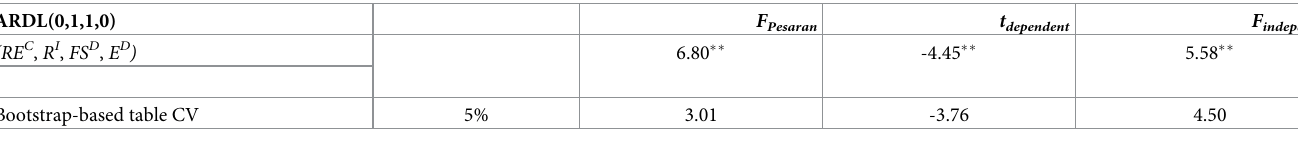
�� statistical sign at 5 percent